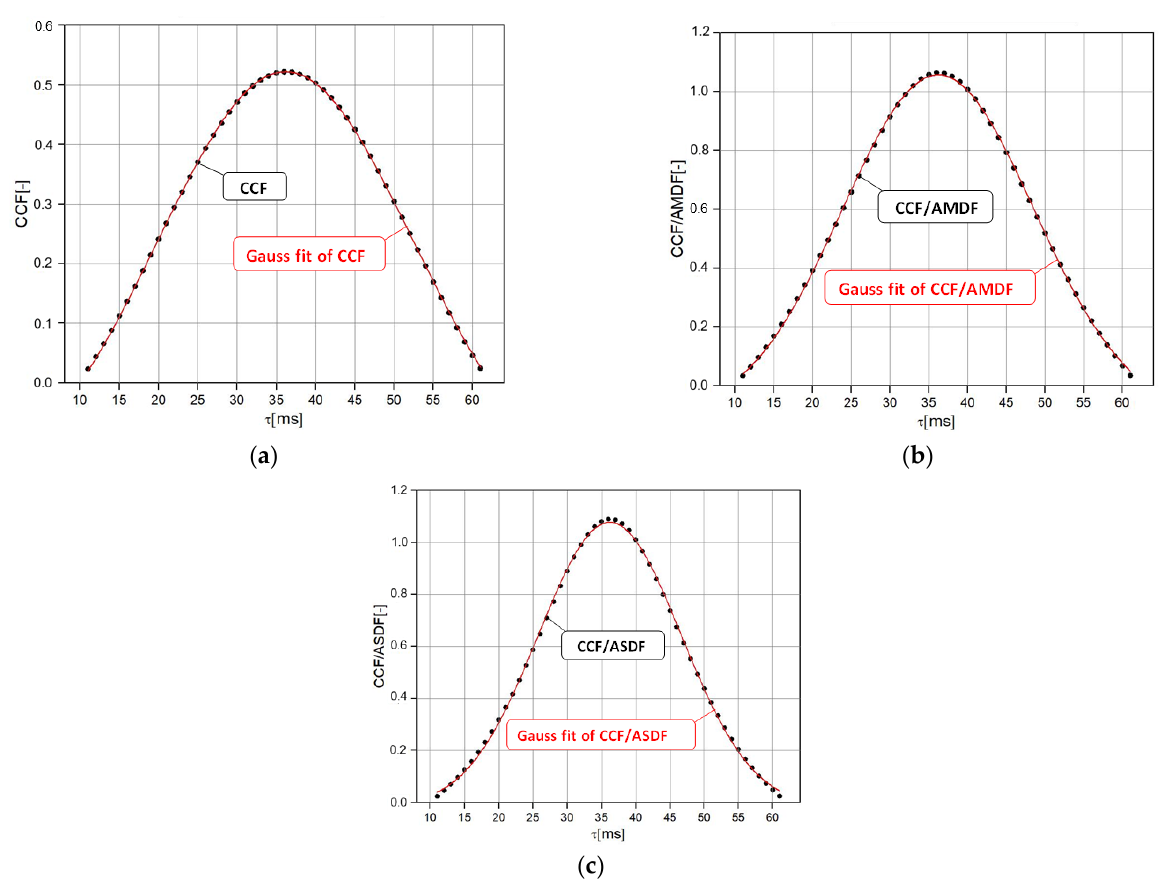
Figure 5. Exemplary results of the Gauss fit in the LIW1 experiment: ( a ) CCF, ( b ) CCF/AMDF,